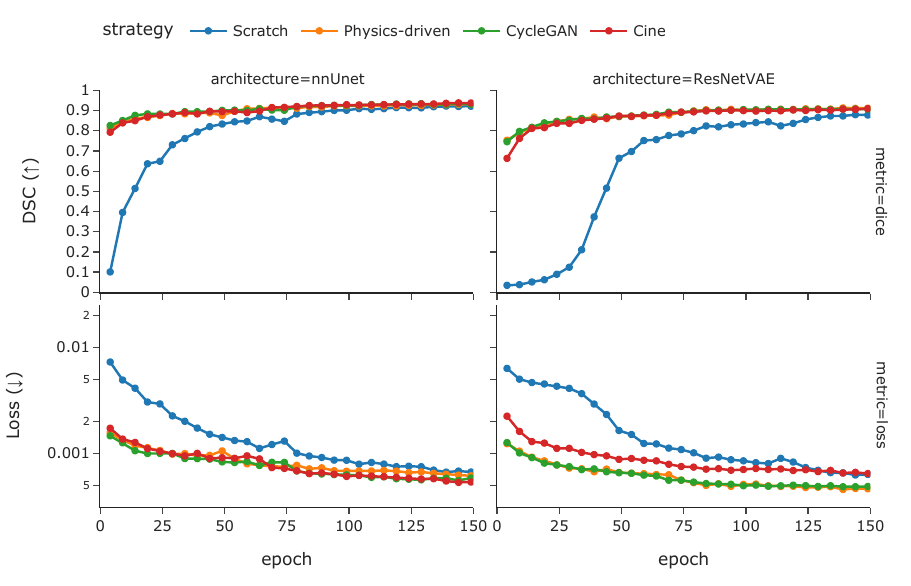
Figure 8. The training Dice coefficient and loss during the 150-epoch weight optimization procedure for different model architectures and pretraining strategies (with cine images, simulated tagged with physics-driven transformation, and simulated tagged with CycleGAN transformation).